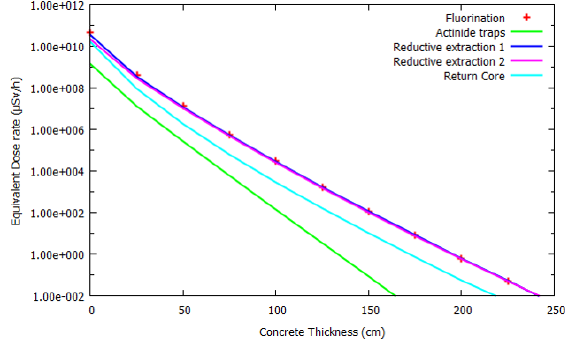
to the gamma source term of each chemical